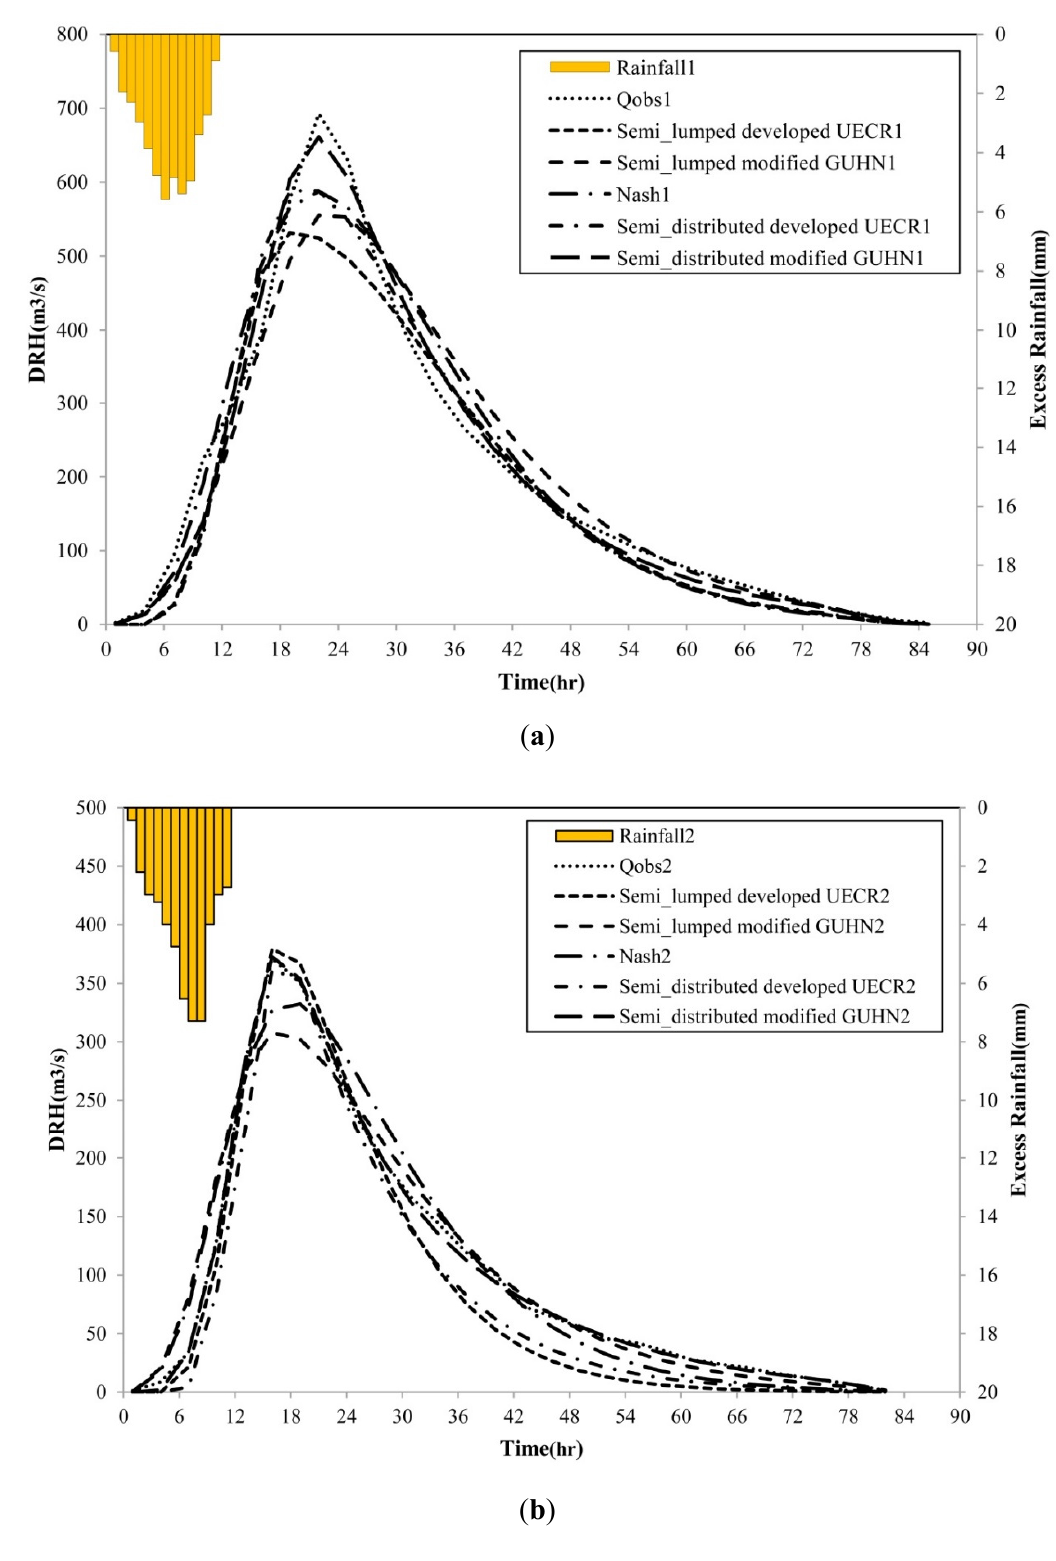
Figure 4. Calibration graphs of Nash, modified GUHN and developed UECR